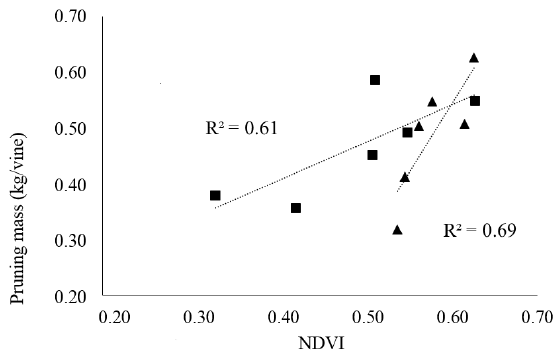
Figure 5. Regression between NDVI unfiltered ( (cid:4) ) and NDVI filtered ( (cid:78) ) with pruning mass weight